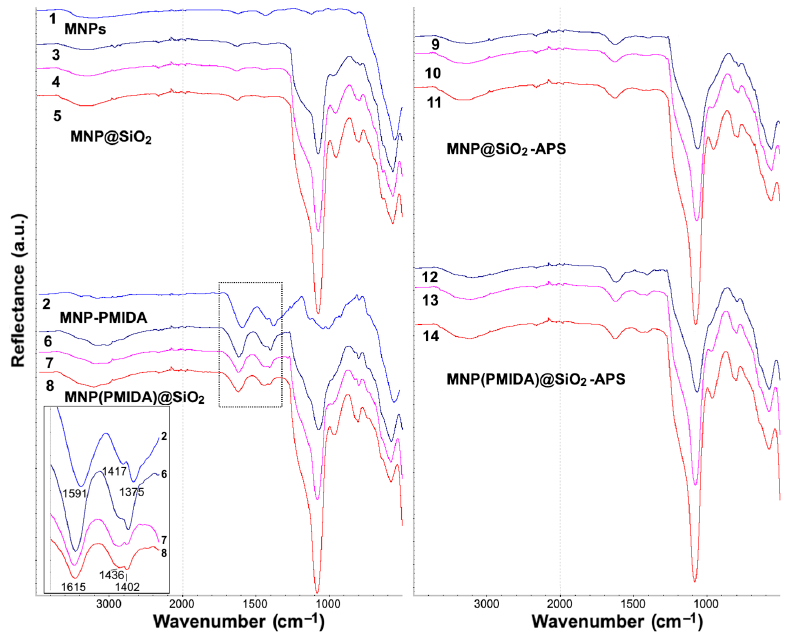
Figure 2. UATR-FTIR spectra of initial MNPs 1 and 2 , as well as SiO 2 -coated ( 3 – 8 ) and SiO 2 /APS-coated NCs ( 9 – 14 ); the inset shows an enlarged fragment of the spectrum in the region 1700–1270 cm − 1 . The spectra are normalized by the height of the bands corresponding to the Fe–O vibrations.